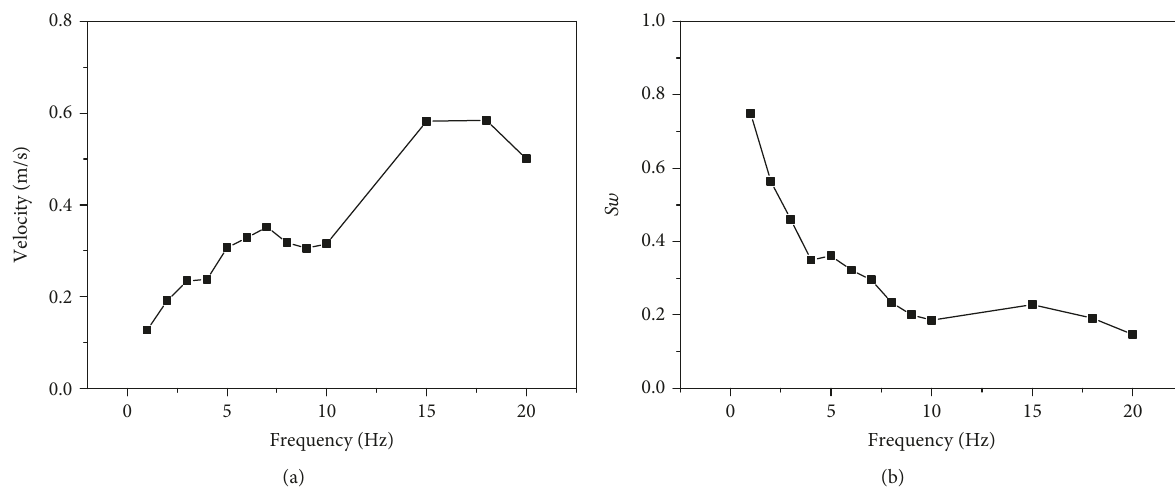
Figure 10: Swimming performance of the new soft robotic fi sh. (a) Swimming velocity at di ff erent frequencies. (b) Swimming number at di ff erent frequencies. Table 6: Comparison of swimming performance of the conventional soft robotic fi sh. Soft robotic fi sh